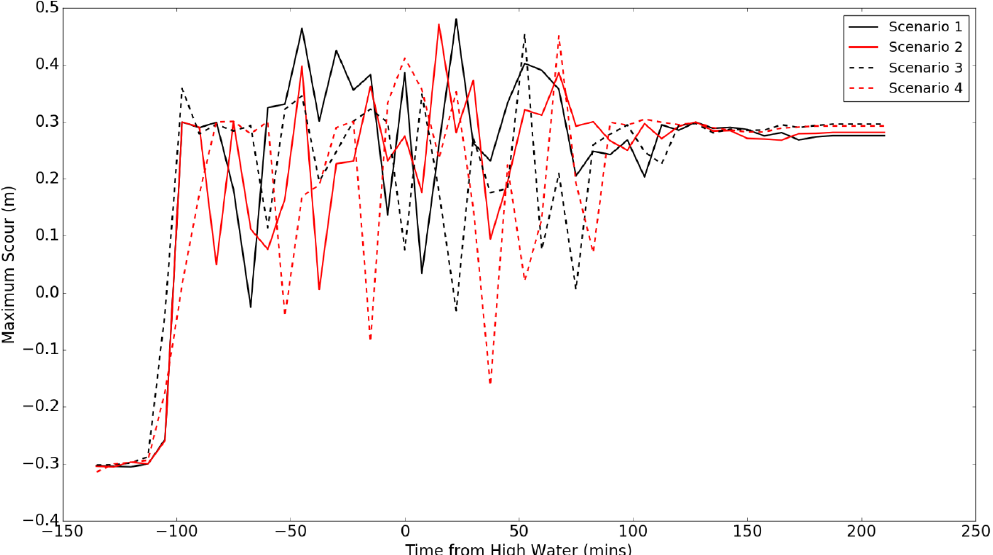
Figure 6. Time-varying scour at the toe of the structure (calculated as time-varying difference in elevation between x-coordinates 12,768 and 12,769 m) for each scenario (see Table 1) with morphology